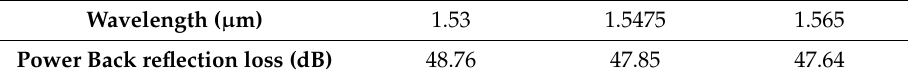
Figure 11. Power back reflection: ( a ) finite difference time domain (FDTD) simulation image and ( b ) power back reflection as a function of cT at 1.53 µm wavelength. Table 4. Power back reflection loss values for the operating wavelengths.